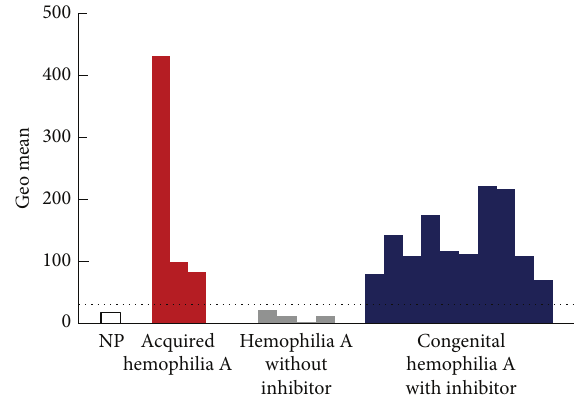
Figure 4: Flow cytometric analysis of factor VIII- (FVIII-) binding antibodies. Plasma samples from 20 normal healthy volunteers (normal pooled plasma), 3 acquired hemophilia A patients, 4 congenital hemophilia A patients without inhibitors, and 10 con- genital hemophilia A patients with inhibitors were assessed using the following procedure. Human recombinant FVIII (rFVIII) was bound to red fluorescent carboxylated polystyrene microbeads (Cyto-Plexpolystyrenemicrobeads)andacertainnumberofhuman rFVIII-bound microbeads were added to serially diluted suspected plasma. After incubation and washing, PE-labeled anti-human IgG antibody was added to the microbeads. After additional incubation and washing, fluorescent intensity was measured using a FACScan flow cytometer. The fluorescence intensity of the anti-human IgG antibody bound to human rFVIII on the microbead surface was expressed as the geometric mean (shown in arbitrary units). The dotted line shows a tentative cutoff value for the inhibitor with the highest geometric mean value in plasma without inhibitor. NP: normal